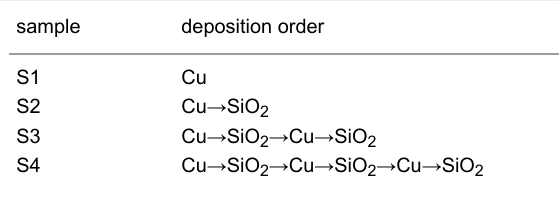
Table 1: Alternating electrodeposition of Cu and SiO 2 for the prepara- tion of different